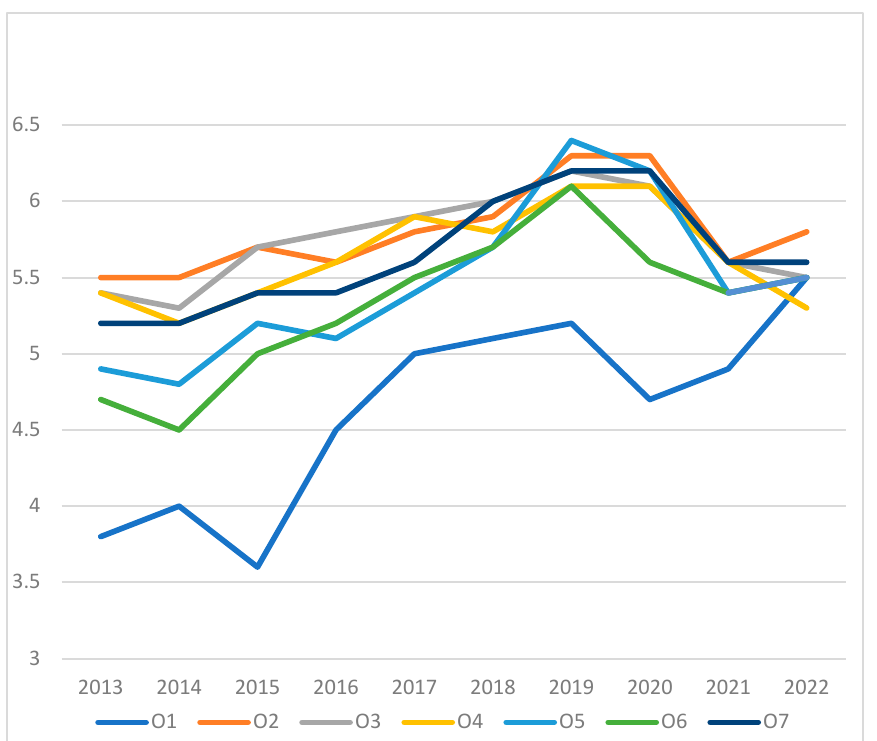
Figure 4. Time Series of Operational Risks Survey Responses, 2013 through 2022 Risk Surveys. Source: Author Created.